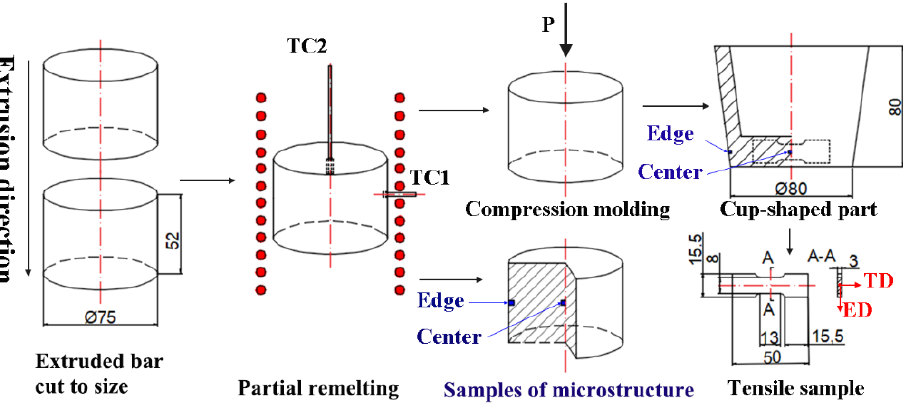
Figure 1. Schematic of the semi-solid process to fabricate the cup-shaped part and samples, unit in